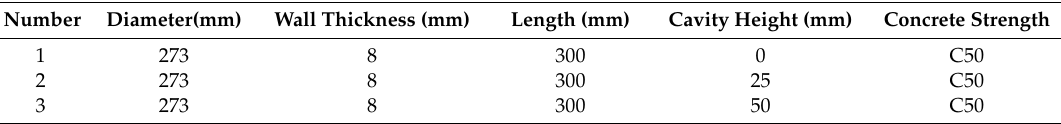
Table 3. Size of